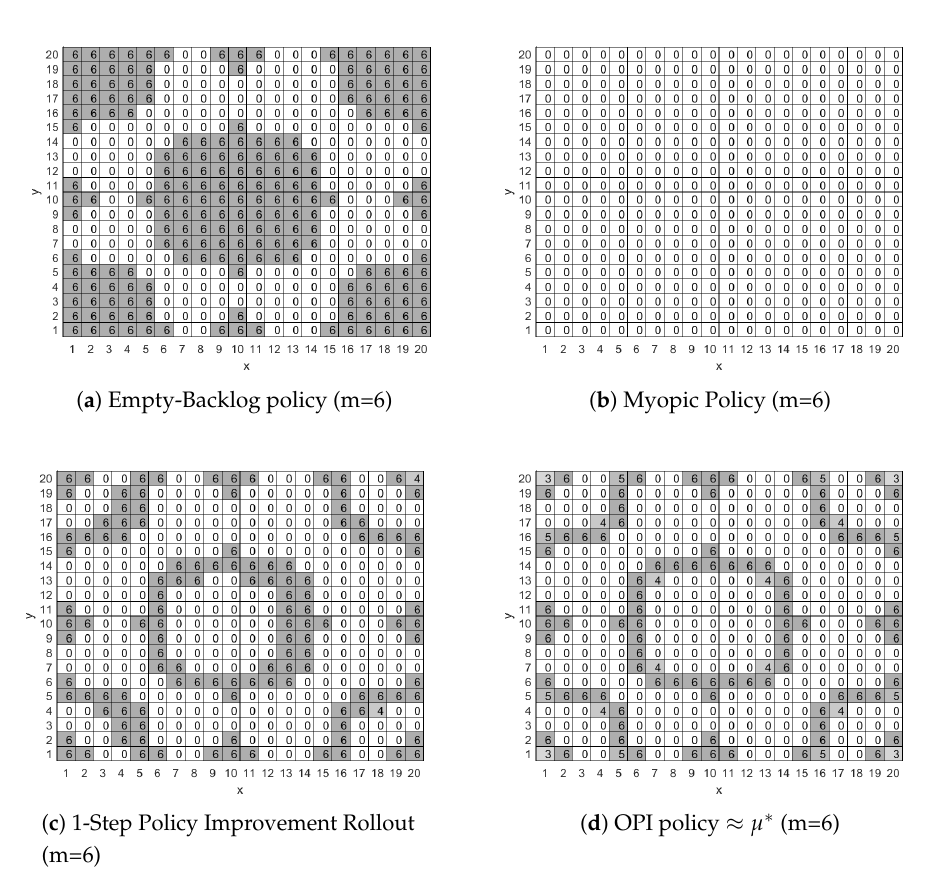
Figure 2. Packet transmission policies for the scenario of Figure 1 for the set of states with m = 6, i.e., with six packets stored in the backlog. The policy produced by the Rollout algorithm with two policy improvement steps is identical to the policy produced by the optimistic policy iteration (OPI)